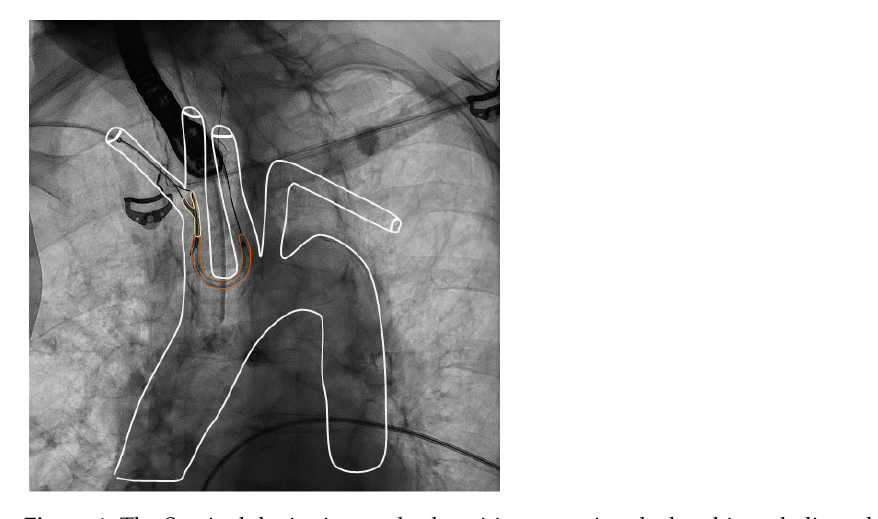
Figure 1. The Sentinel device in standard position, covering the brachiocephalic and left common carotid artery. Anteroposterior view. Aortic arch and supraaortic vessels are depicted in white, the device is depicted in yellow for better visibility.